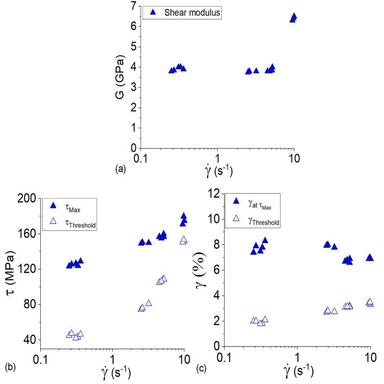
Effect of strain rate on the (a) shear modulus, (b) maximum shear stress (τr) and threshold shear stress (τy), and (c) shear strain at maximum shear stress (γr) and threshold shear strain (γy) for RO-A-SMC composite.